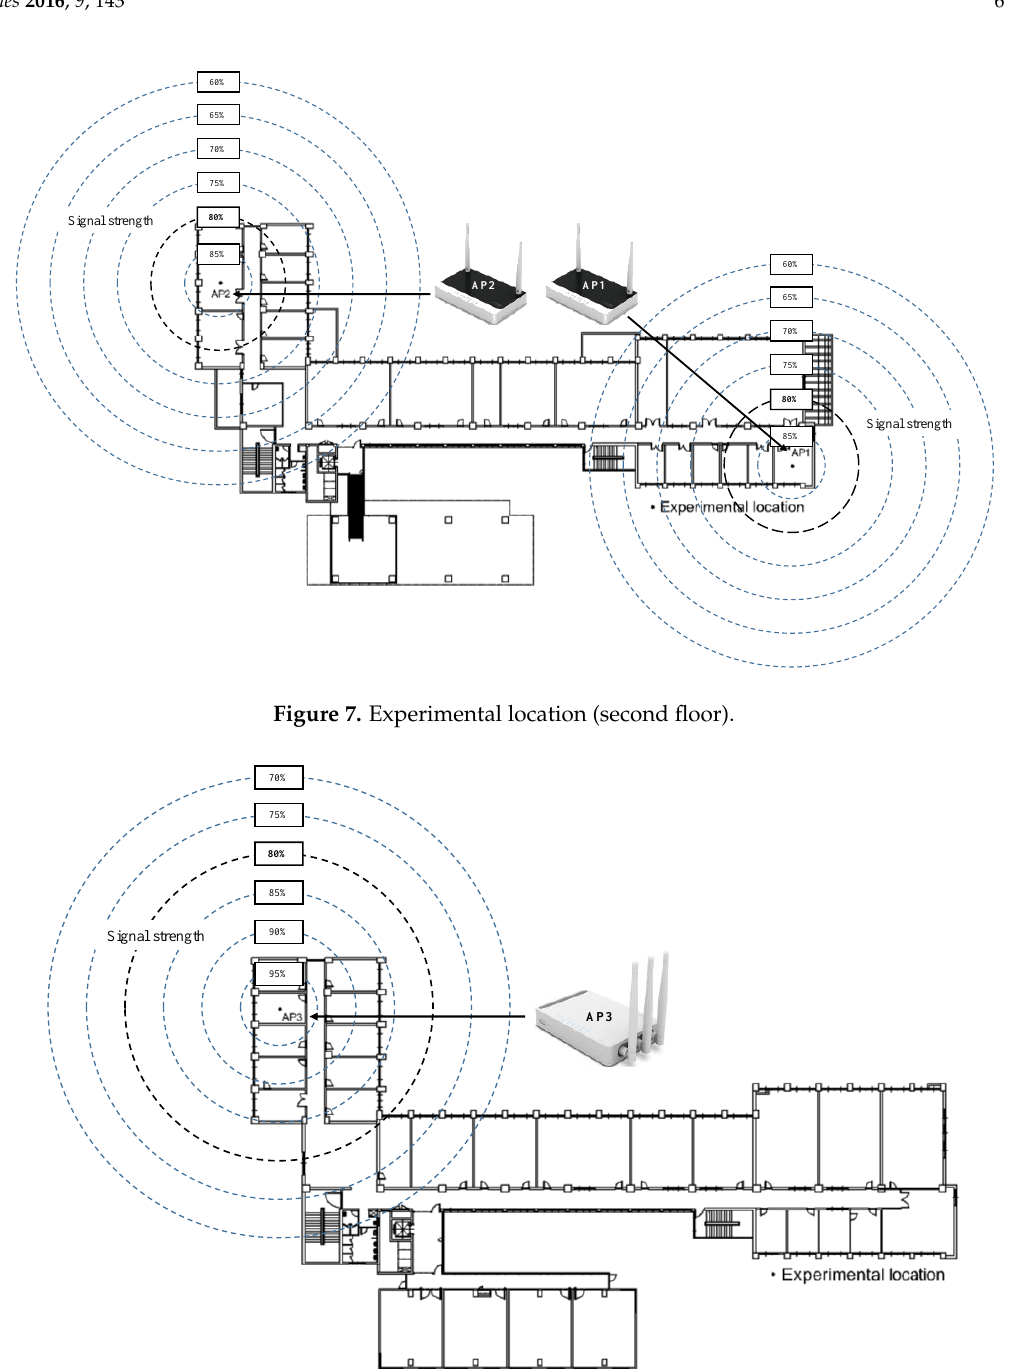
Figure 8. Experimental location (fourth floor).